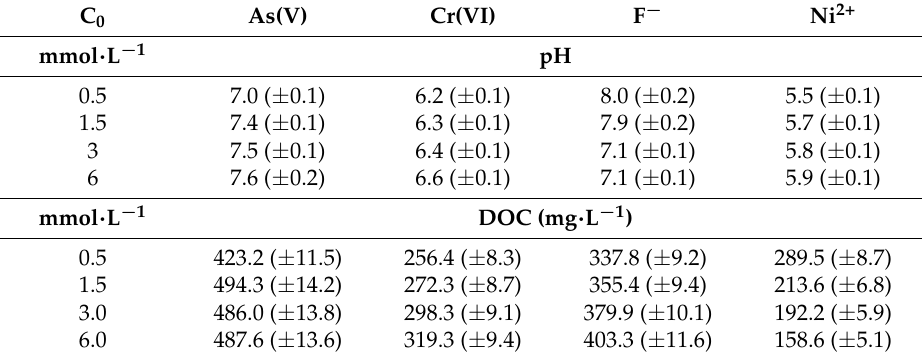
Table 2. Solution pH and DOC (mg · L − 1 ) after As, Cr, F, and Ni sorption on wheat straw, for different concentrations added (C 0